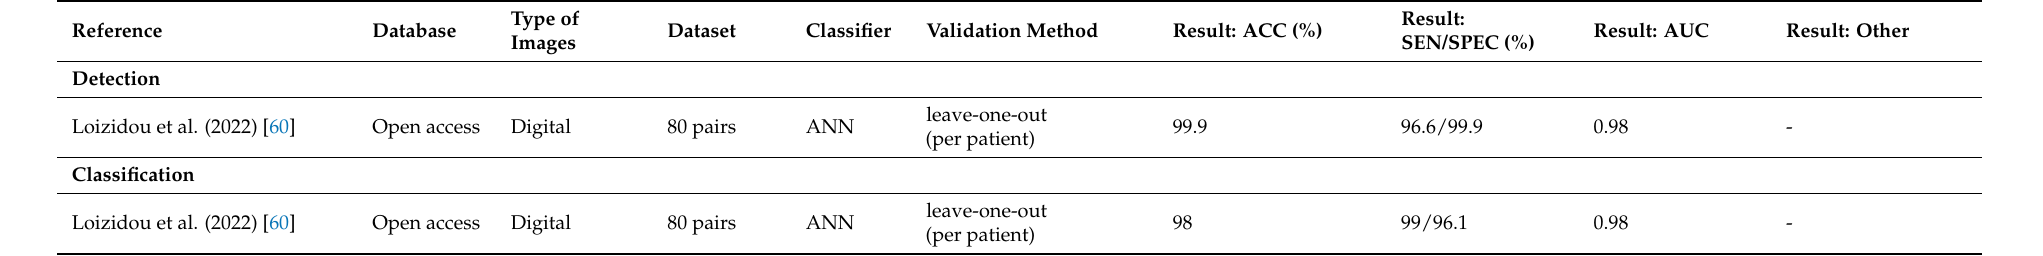
Table 7. Comparison of algorithms for the diagnosis of masses in sequential mammograms using temporal subtraction and feature-based machine